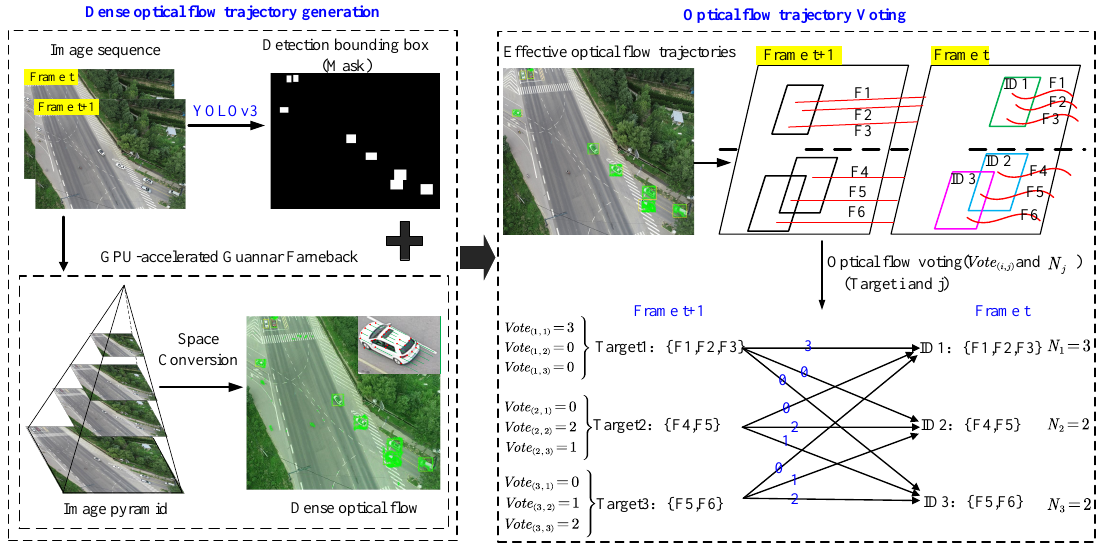
Figure 4. Dense-optical-flow-trajectory generation and voting process. In this paper, we combined a GPU-accelerated Gunnar Farneback algorithm with detection results to generate effective optical-flow trajectories. To represent the voting process, we assumed that there were three detection targets in Frame t + 1, and the optical-flow trajectories of these targets were { F 1, F 2, F 3 } , { F 4, F 5 } , { F 5, F 6 } ,